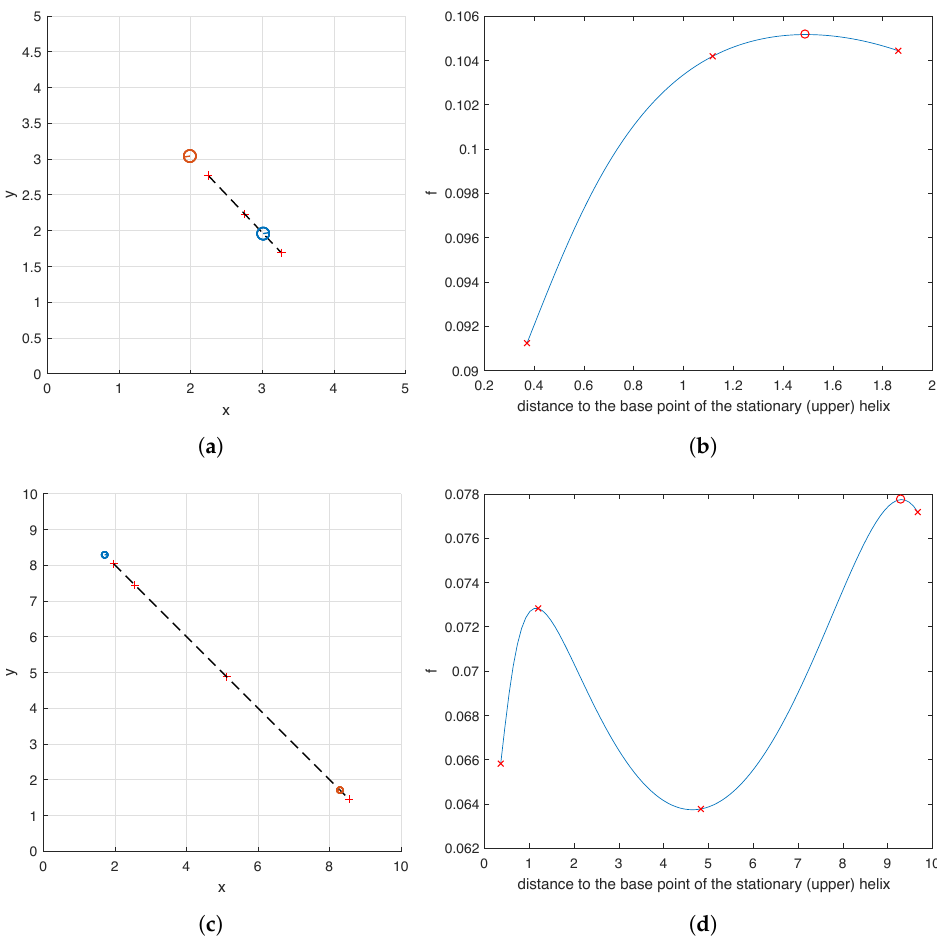
Figure 8. The graph of f ( θ ) as the location of one helix varies along a straight line while the location of the other helix and the phase shifts of both helices remain fixed. The two rows correspond to two sizes of the flow meter (7): W = 5 ( a , b ) and 10 ( c , d ). ( a , c ): The top view of the optimal carpet with the path of the moving helix marked by a dashed line. ( b , d ): The value of f ( θ ) as the distance between the base points of the helices increases. In ( a – d ), the crosses correspond to a few sample locations along the dashed